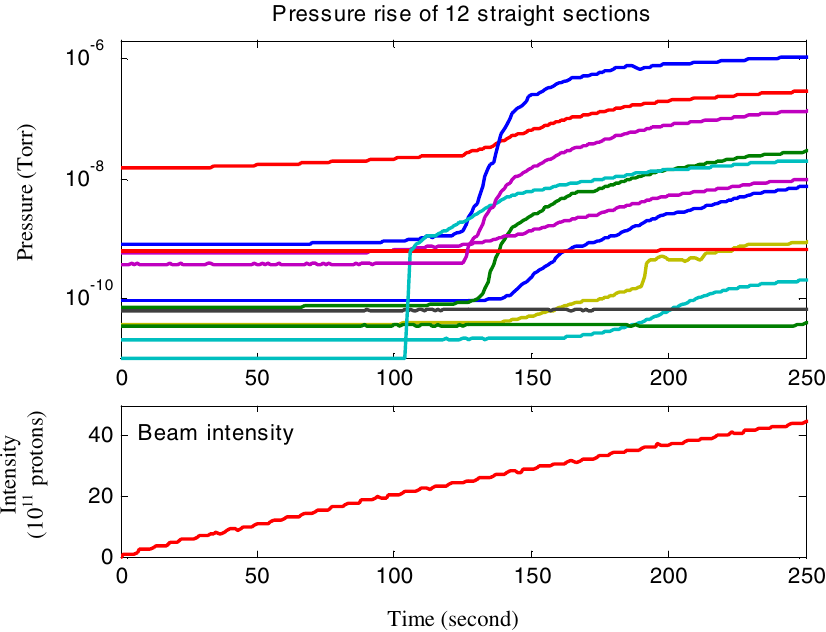
FIG. 4. (Color) Electron cloud induced pressure rise observed during injection in 9 out of the 12 single (yellow) beam straight sections in 2003. About 50 bunches were injected in the 110-bunch mode (bunch spacing of 108 ns), with 10 11 protons per bunch. Pressure rise values differ by 4 orders of magnitudes, depending on the locations. Usually in RHIC, one or two sections with the highest pressure rise limit the beam intensity.